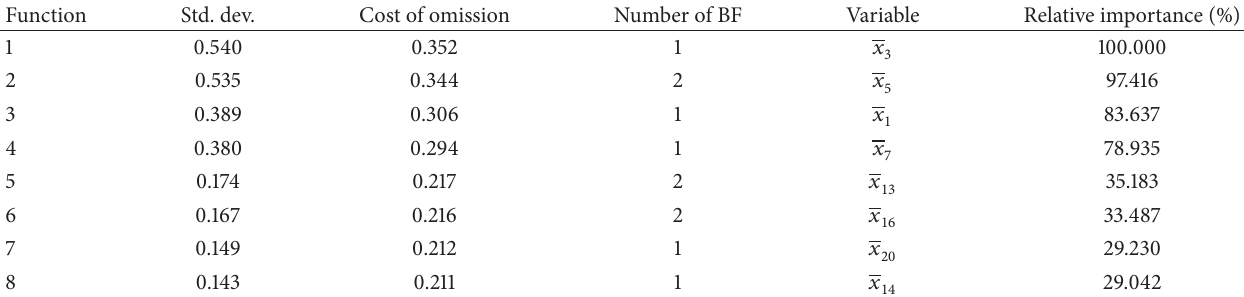
Table 6: Basis functions and important explanatory variables for the MARS model with ( 𝜌 , 𝛿 𝑖 ) = (0.5, 1.0).